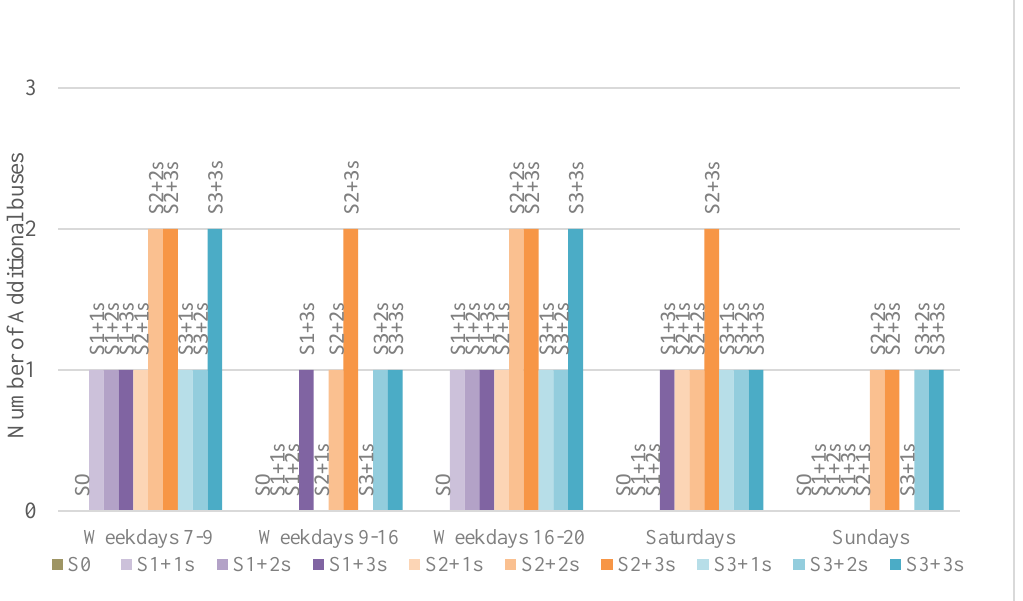
Figure 4. Number of additional vehicles in different sub-scenarios to maintain existing